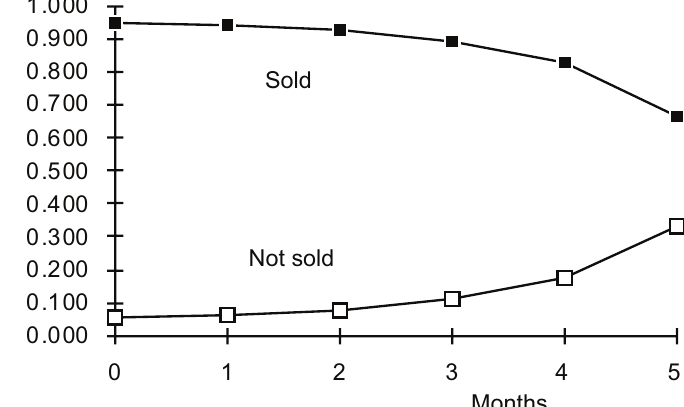
figure 2. Case example. Probability of units up being sold/not